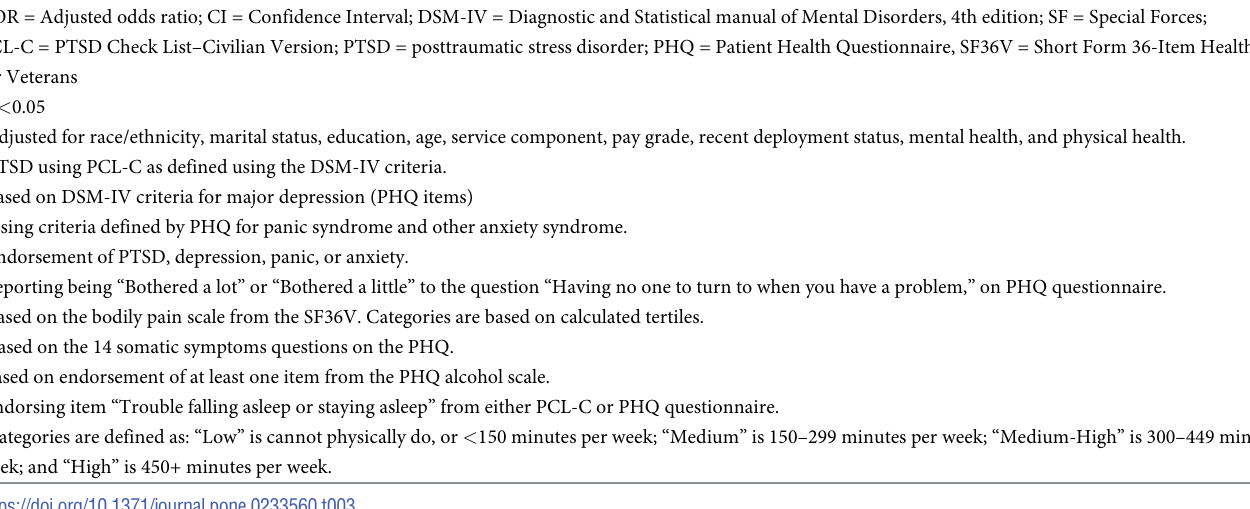
Forces GeneralPurposeForces